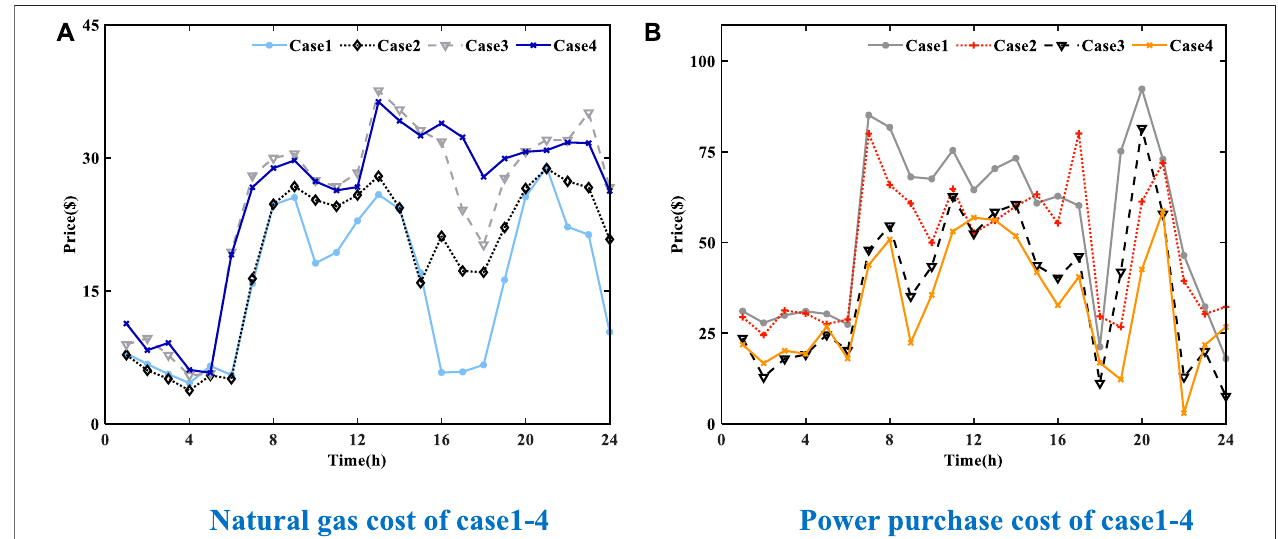
FIGURE 6 | Natural gas cost and power purchase cost of Case1 – 4. (A) Natural gas cost of Case1 – 4. (B) Power purchase cost of Case1 – 4.